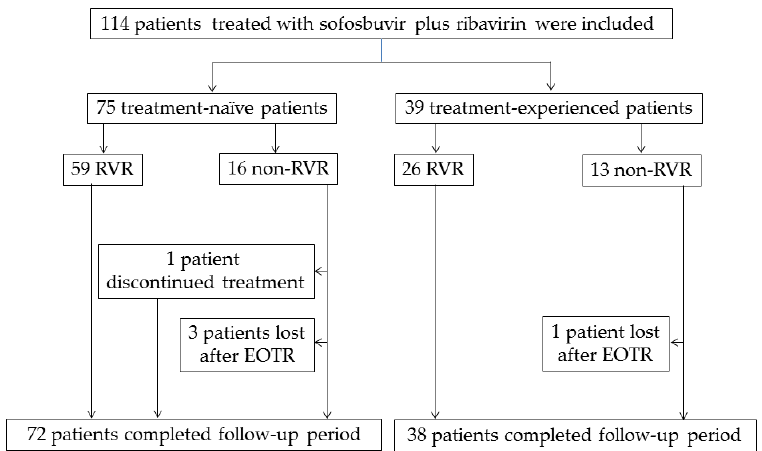
Figure 1. Study profile. Of 114 patients, 113 completed the combination of sofosbuvir plus ribavirin, and only one patient discontinued treatment. RVR, rapid virologic response; EOTR, end of treatment response.